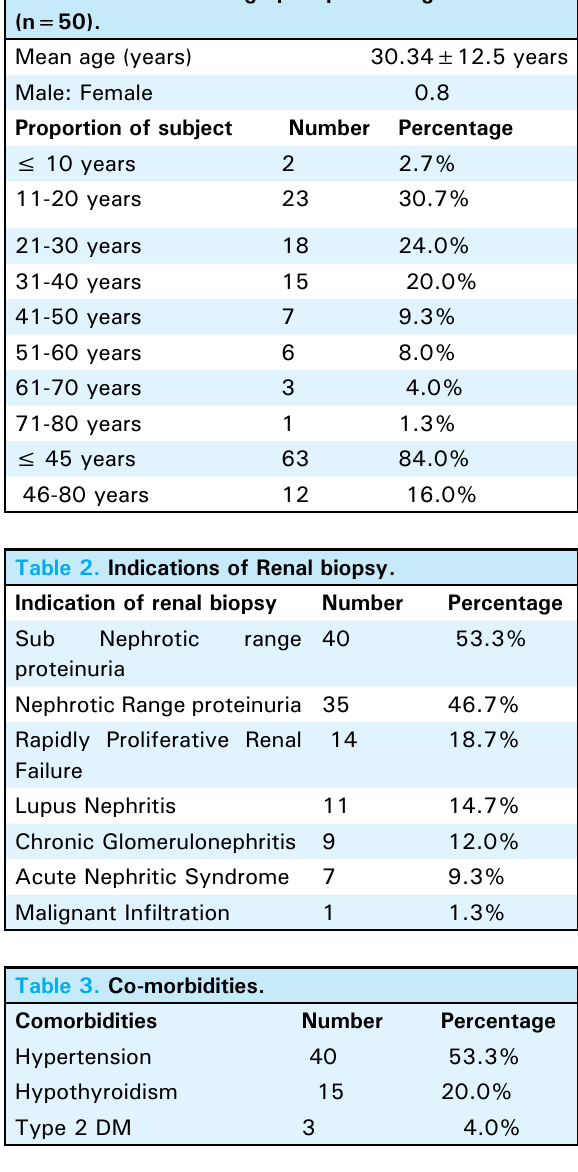
table 1. Patient Demographic profile/ Age distribution